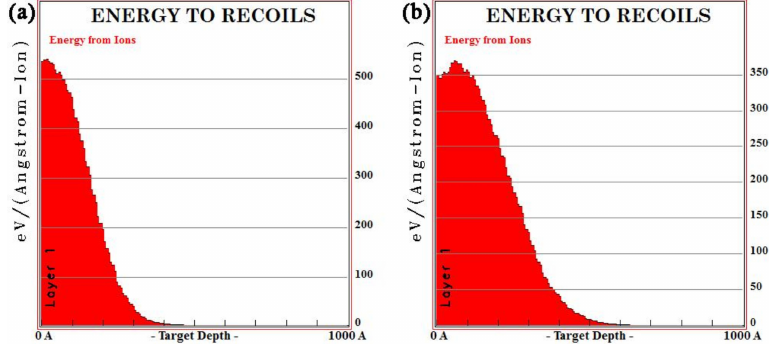
Figure 14. SRIM simulation of mean ion energy during ion implantation of ( a ) La and (b ) Y into